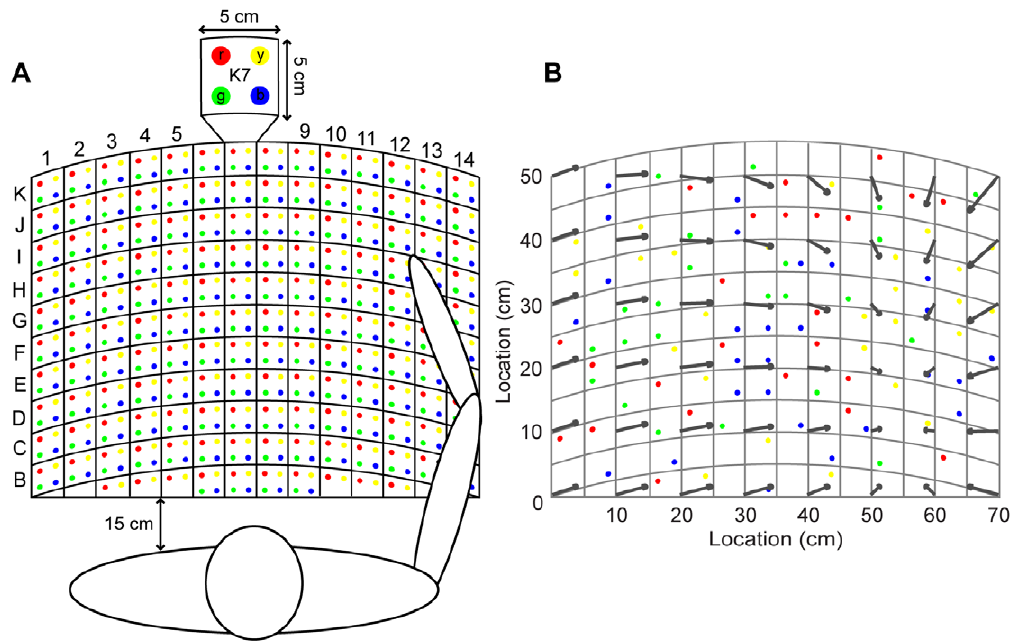
Figure 1. Experimental setup. (A) Each square was labeled with a row letter, a column number, and four colored circles (red, yellow, green, and blue). (B) The colored targets represent an example of a target set. The superimposed vector field represents an example of a spatial structure of mean errors generated with the fourth-order regression. The beginning of the arrow indicates the target where the finger was positioned and the arrowhead indicates where the subject’s estimation of the target.